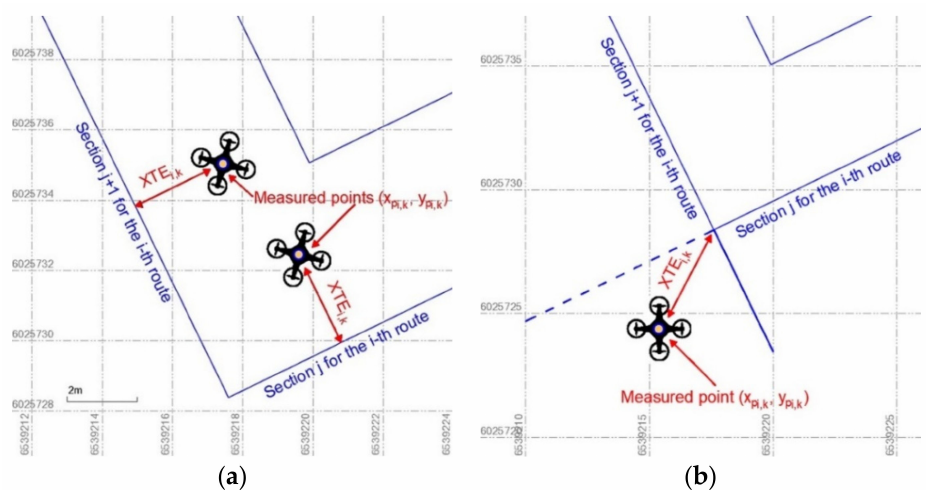
Figure 3. The graphical method for determining the distance between the measurement point and the designed route for variants I ( a ) and II ( b ).